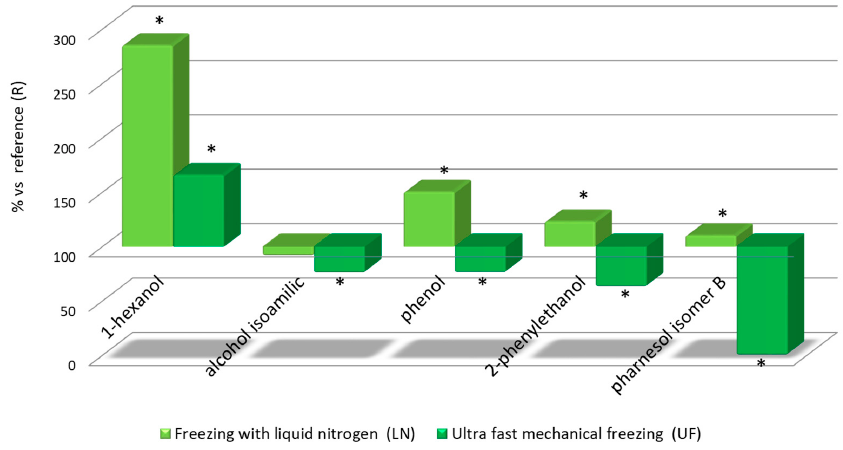
Figure 3. Relative levels of volatile terpenoids in the three wine types: Relative values for LN and UF vs R. * Significant difference vs the R wines ( p -value < 0.05).